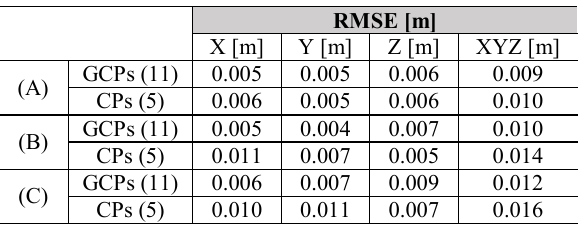
Table 4 . Mean errors on GCPs and CPs (rural chapel datasets). (A) Visible dataset; (B) Thermal dataset (Workflow 1), (C) Thermal dataset (Workflow